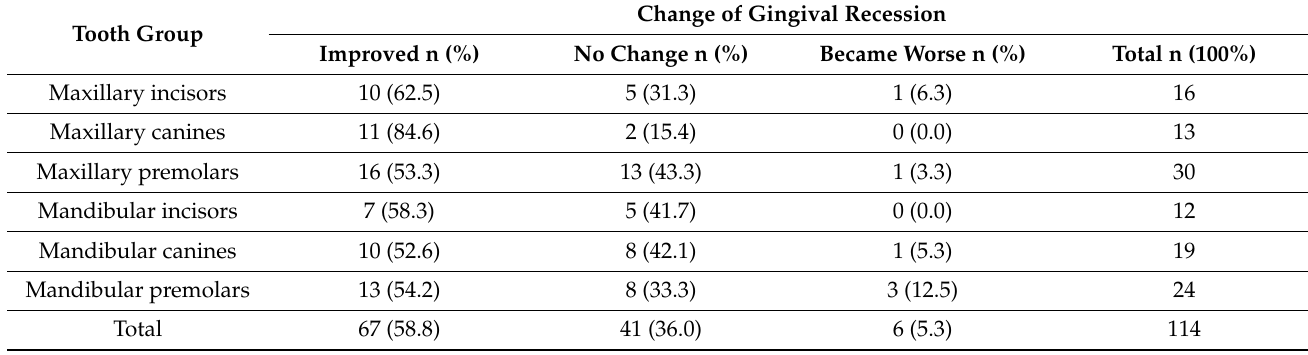
Table 2. Change of gingival recession in different groups of